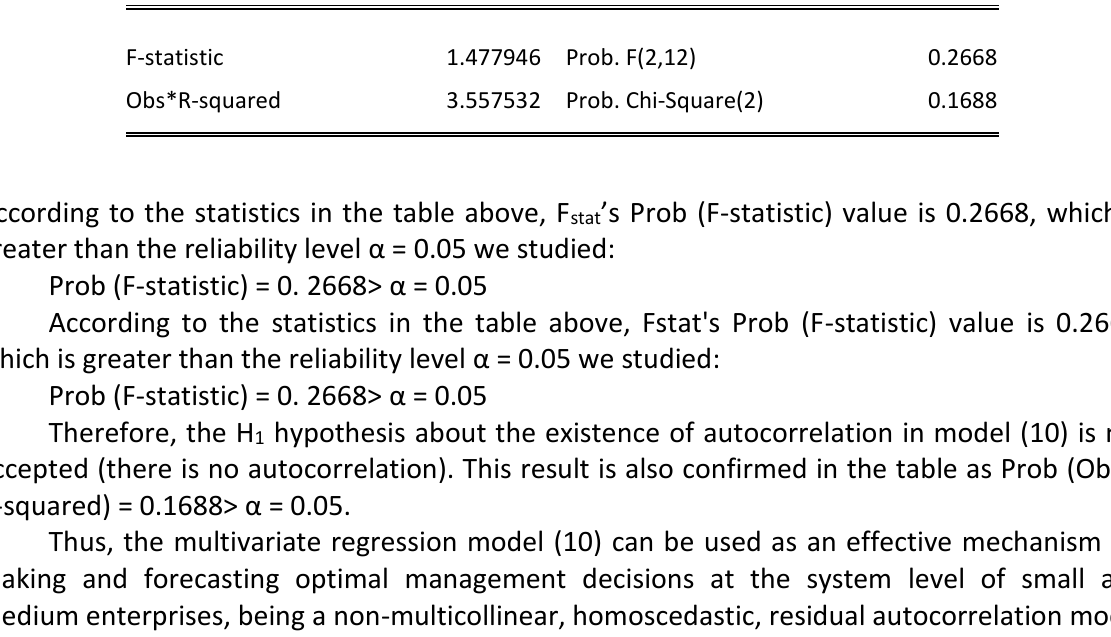
Table 8. Breuş – Qodfri testi il ə avtokorrelyasiyanın yoxlanmasının statistikası Breusch-Godfrey Serial Correlation LM